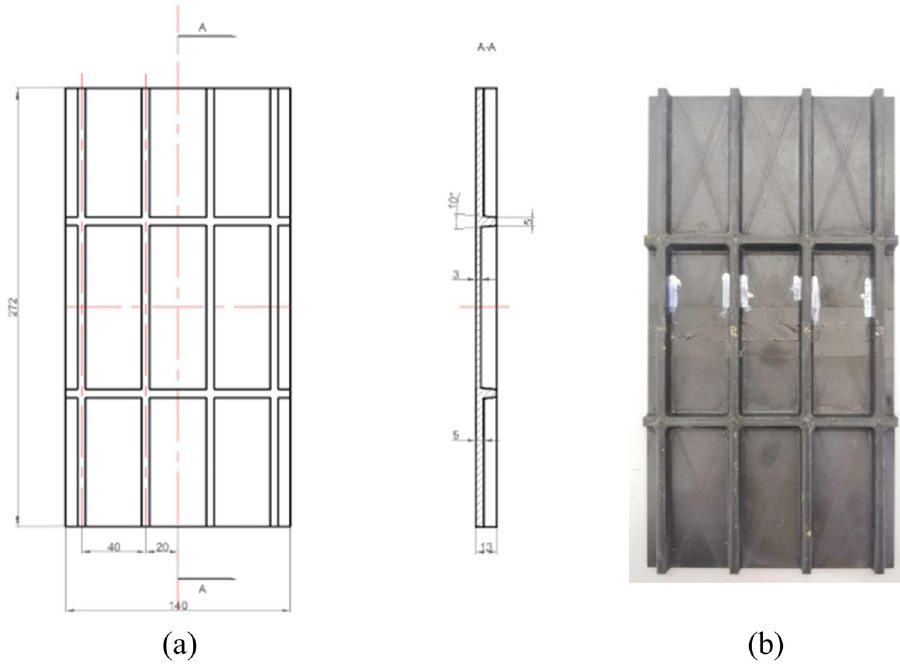
Figure 1: ( a ) The geometry dimension ( mm ) ; ( b ) the reinforced composite skin structure